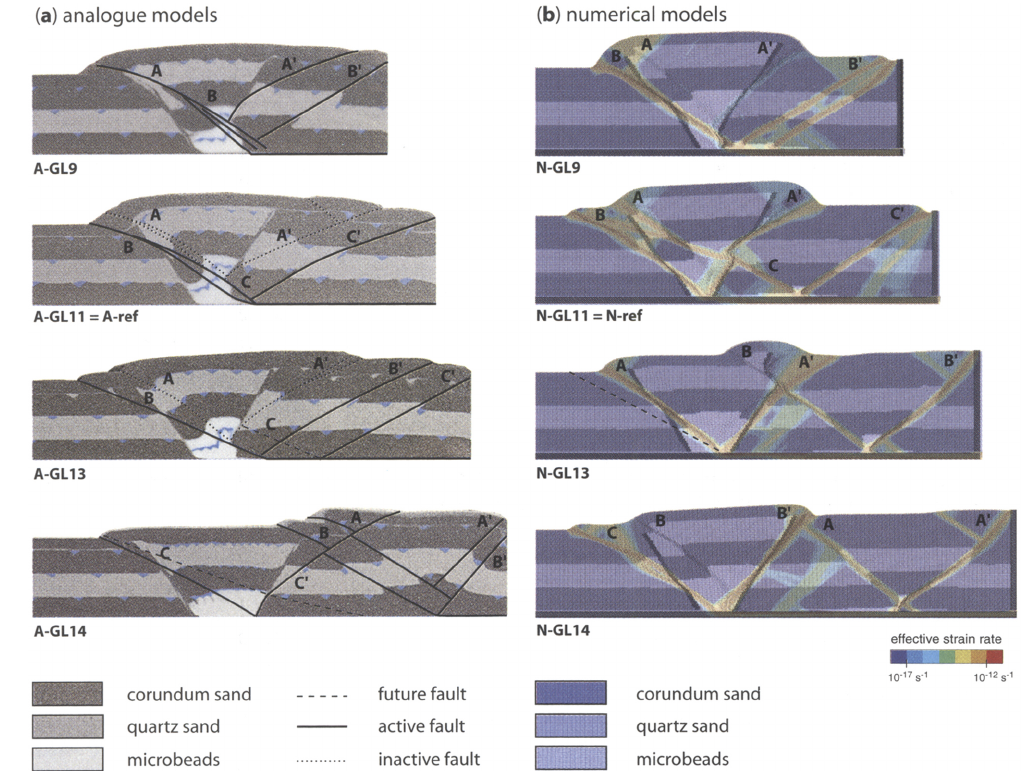
Figure 18. Example of analogue–numerical model comparison (Panien et al., 2006a). Both set-ups aim to simulate orthogonal inversion of a pre-built basin. Pre-rift layer thickness is set to 3.5cm. The numerical models are obtained with a finite element method. Reproduced with permission from the Geological Society,